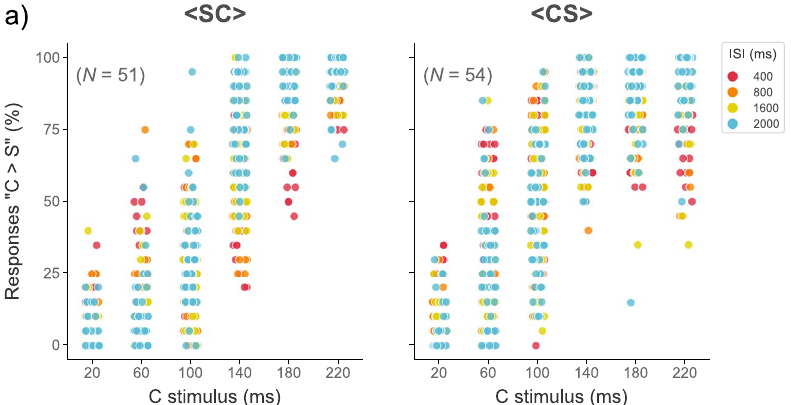
Figure 2. “C > S” responses. ( a ) Percentage of “C > S” responses plotted as a function of the C stimulus. Data points depict individual mean responses at each ISI level. For the <SC> group participants tend to make more mistakes at the 140-ms C stimulus, whereas for the <CS> group they tend to make more mistakes at the 100-ms C stimulus. We analyzed these behavioral responses with generalized linear mixed models (GLMMs) to estimate a single model across all